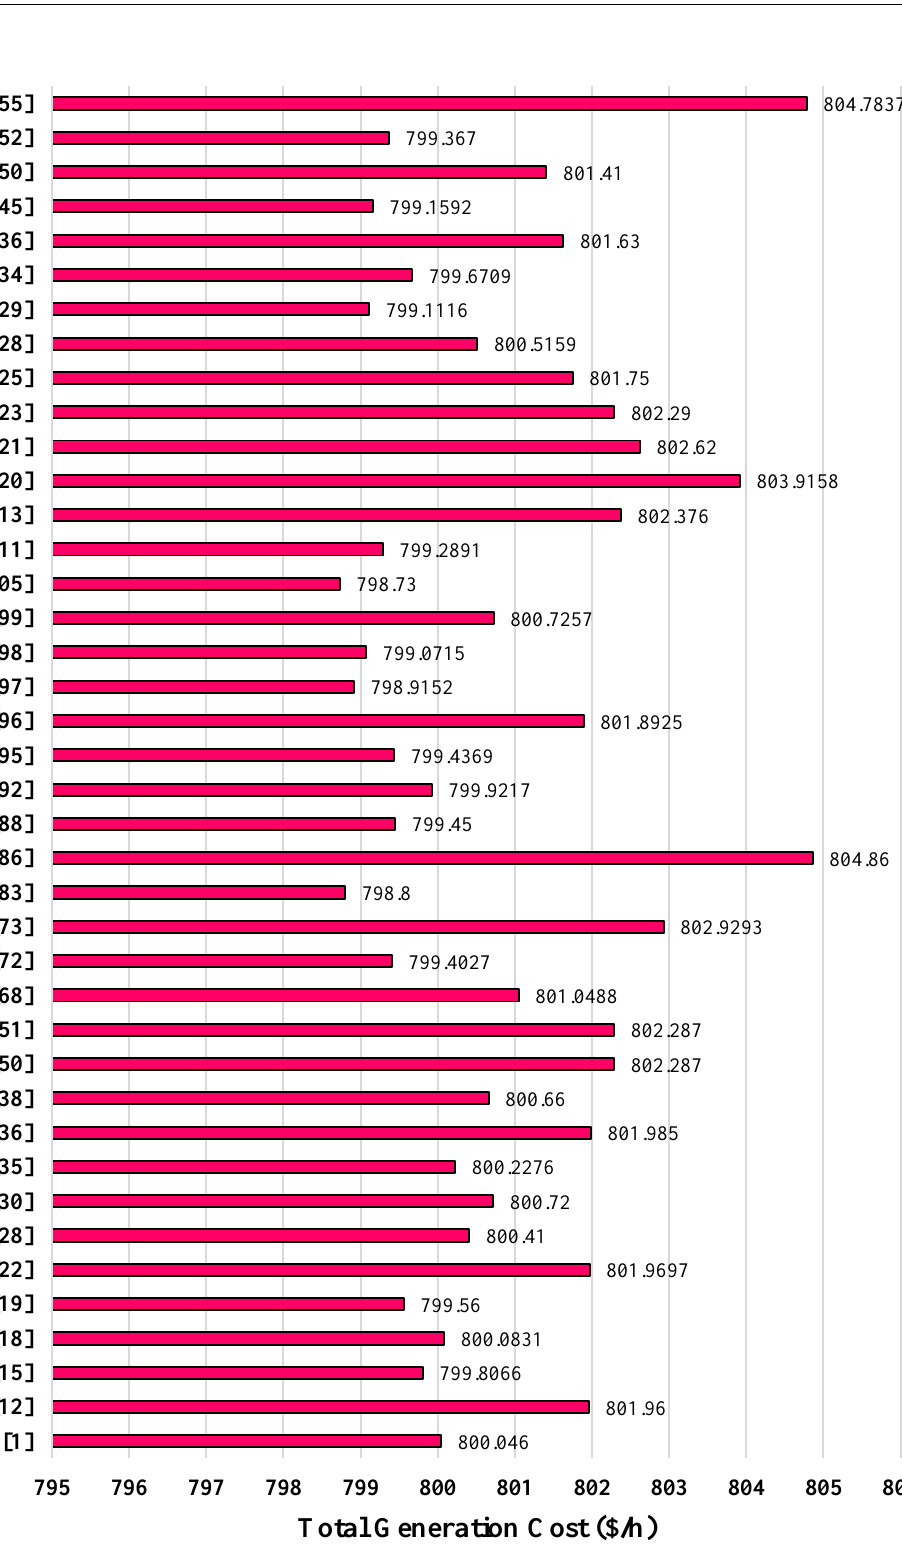
Figure 9. Comparison of cost obtained by different algorithms for IEEE 30-bus test system based on objective function (6).